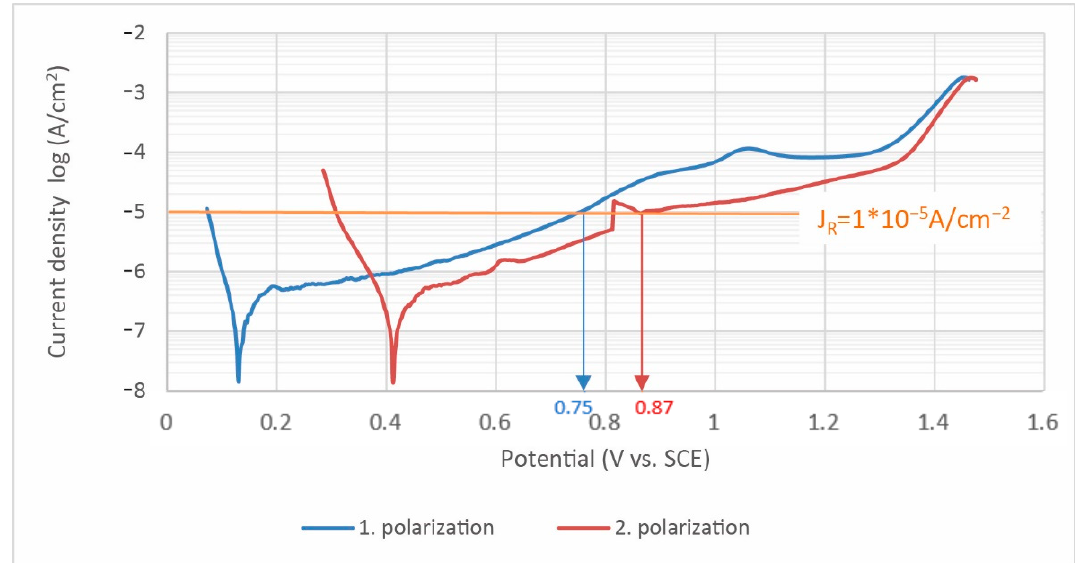
Figure 5. Polarization curves of 1.4441 for first and second polarization in physiological solution .